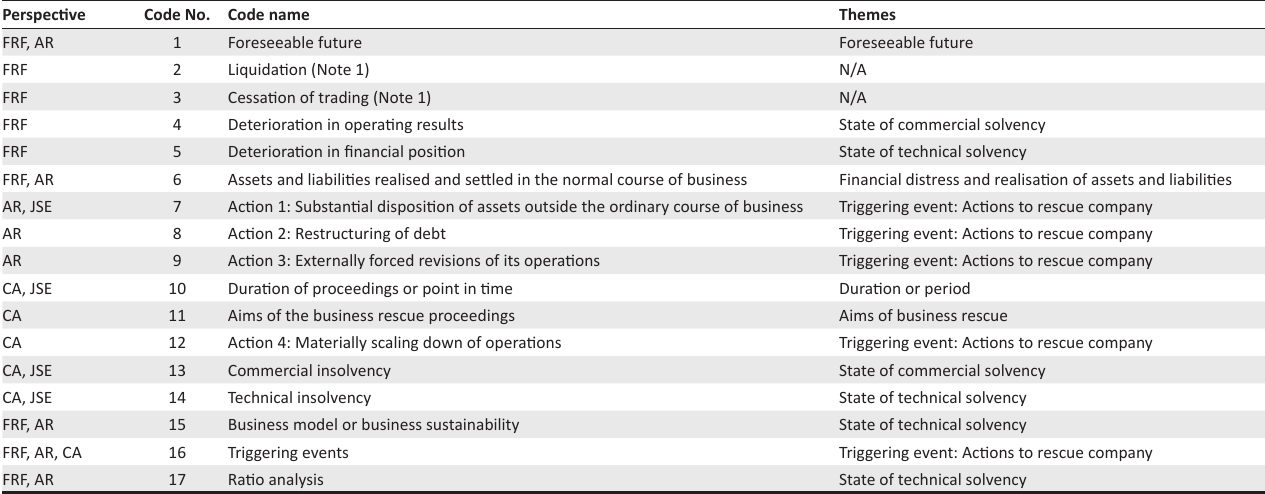
TABLE 2: Possible indicators of a going concern.